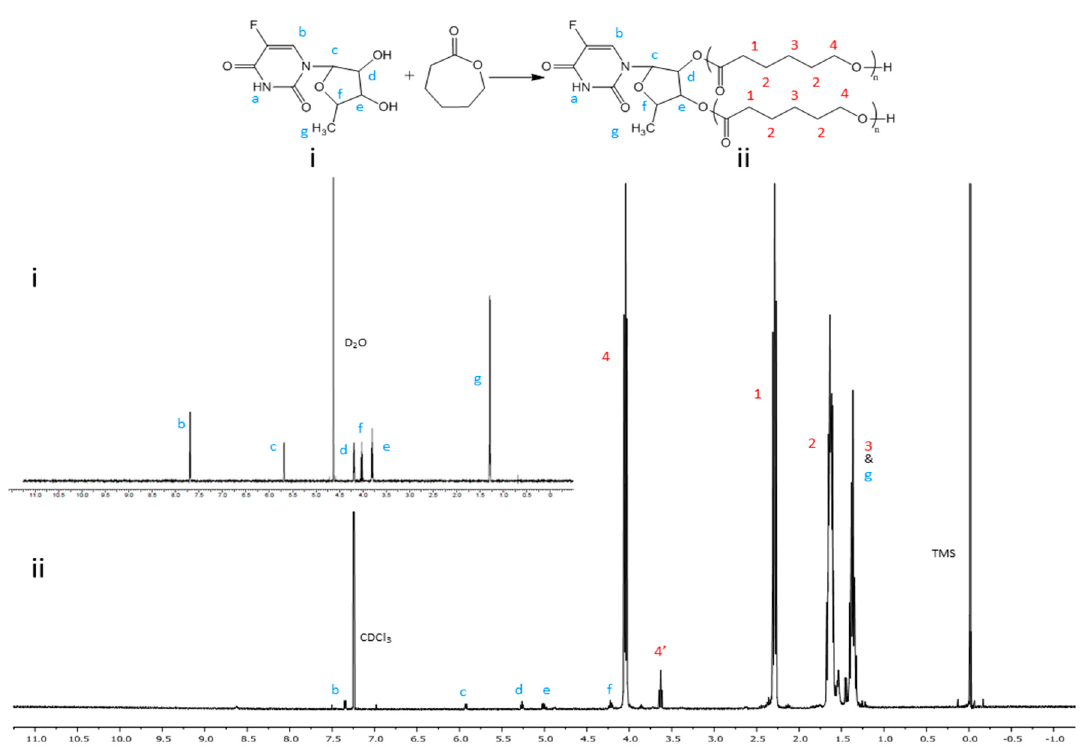
Figure 2. 1 H NMR spectra of ( i ) 5’-DFUR and ( ii ) 5’-DFUR-PCL. Nanomaterials 2018 , 8 , x FOR PEER REVIEW Table 1. Characterization of 5’-DFUR-PCL-MPEG and MPEG 350 -PCL-MPEG amphiphilic copolymer.